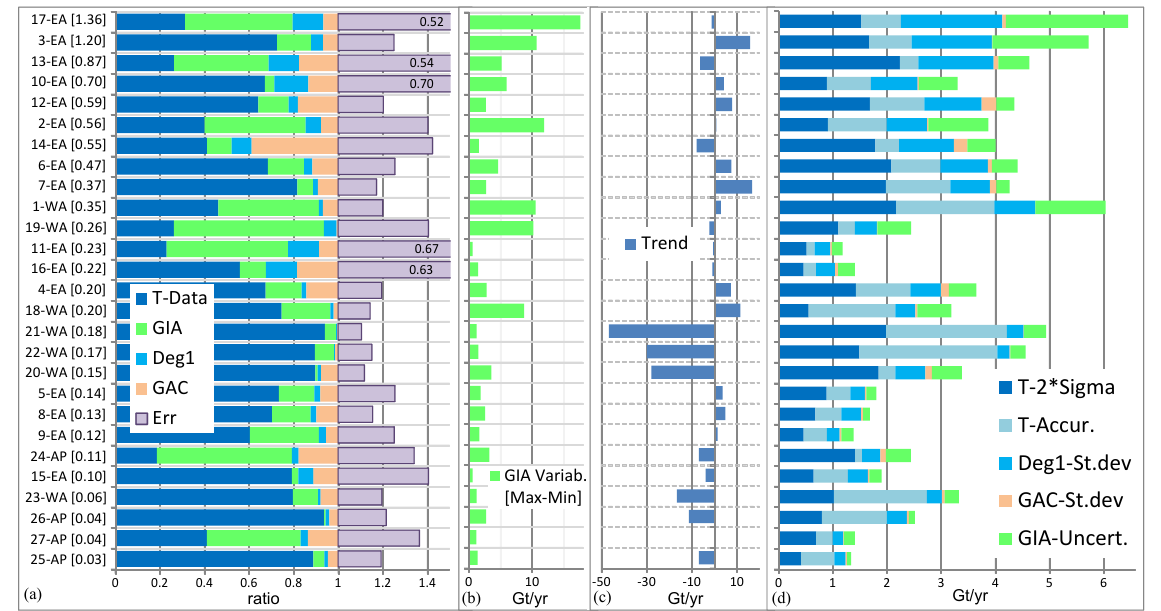
Fig. 8. Trend summary for Antarctica.The labels for vertical axis on the left are the same for the 4 panels and indicate the basin as in Fig. 4. (a) shows each relative contribution to the trend, the data (blue), GIA (green), degree-1 (Deg-1, sky blue) and GAC (light orange). The relative error (violet) is shown on top of the trend bar. (b) shows the GIA variability (in Gt yr − 1 ) as the difference between the maximum and the minimum values for GIA corrections among the four different models used. (c) shows the total trend in Gt yr − 1 for the average time series. (d) shows the total error (in Gt yr − 1 ) on the trend as sum of each of its component: 2 × σ from the trend computation (blue), the trend accuracy error (light blue), the standard deviation (st. dev.) for the trend on degree-1 (sky blue), the GAC st. dev. (light orange) and the GIA uncertainties (green) as max on GIA uncertainties among all